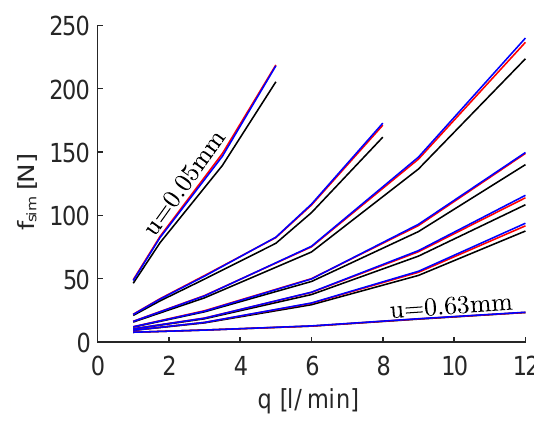
Figure 9: f sim (q) for HV at 20(black), 40(red), Figure 10: f sim (q)